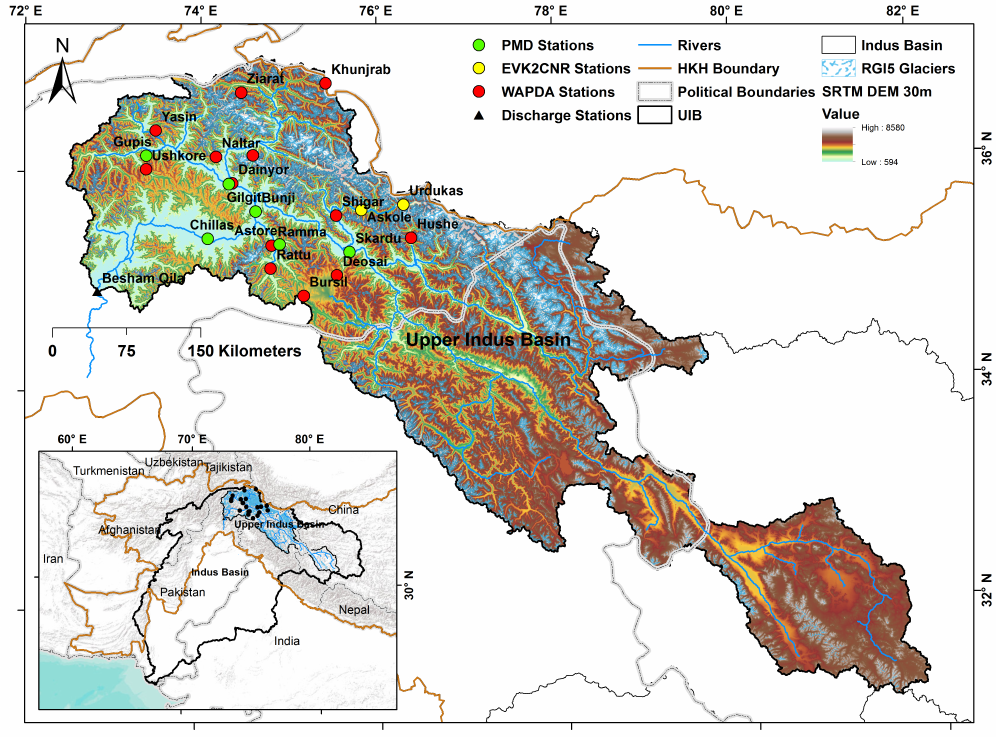
Figure 1. The upper Indus basin (UIB) along with the station network, Hindukush-karakoram-Himalayan (HKH) Ranges and the